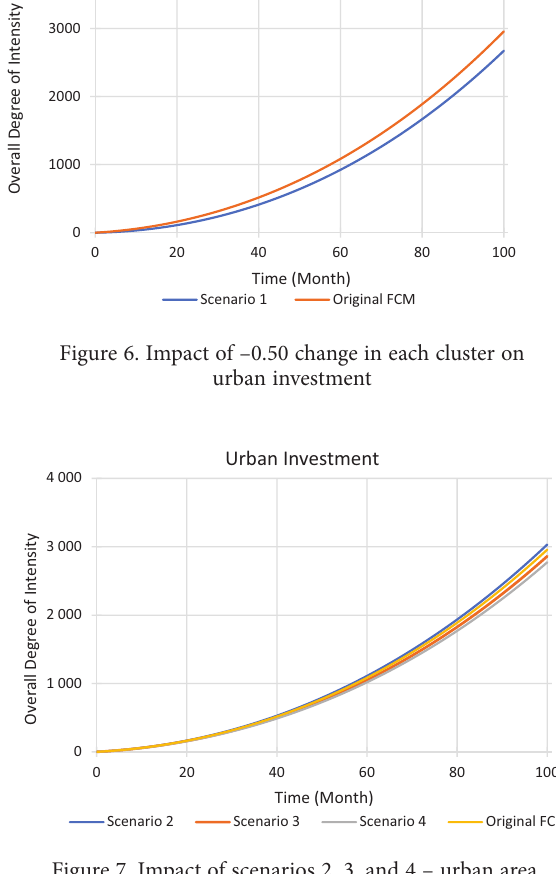
Figure 7. Impact of scenarios 2, 3, and 4 – urban area characteristics’ effect on urban investment